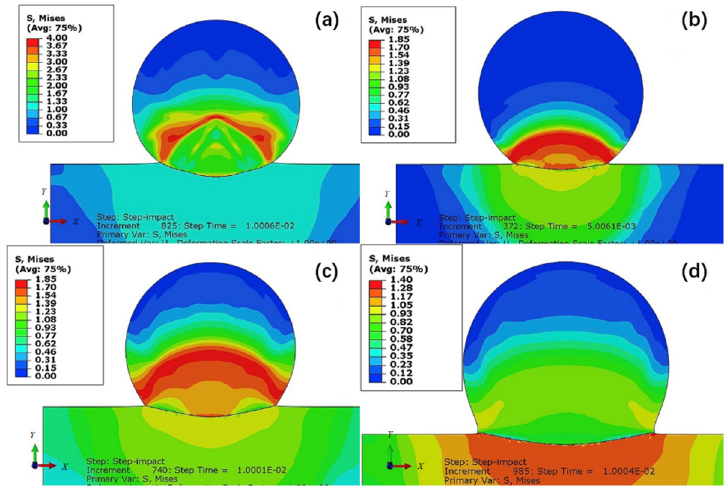
Figure 15. Simulation of Von Mises (VM) equivalent stress contours at 10 ns with different Re. ( a ) Re = 1.77 × 10 − 9 , ( b ) Re = 3.35 × 10 − 5 , ( c ) Re = 4.45 × 10 − 5 , ( d ) Re = 0.229. Reprinted with permission from [70] Copyright 2021 Elsevier.